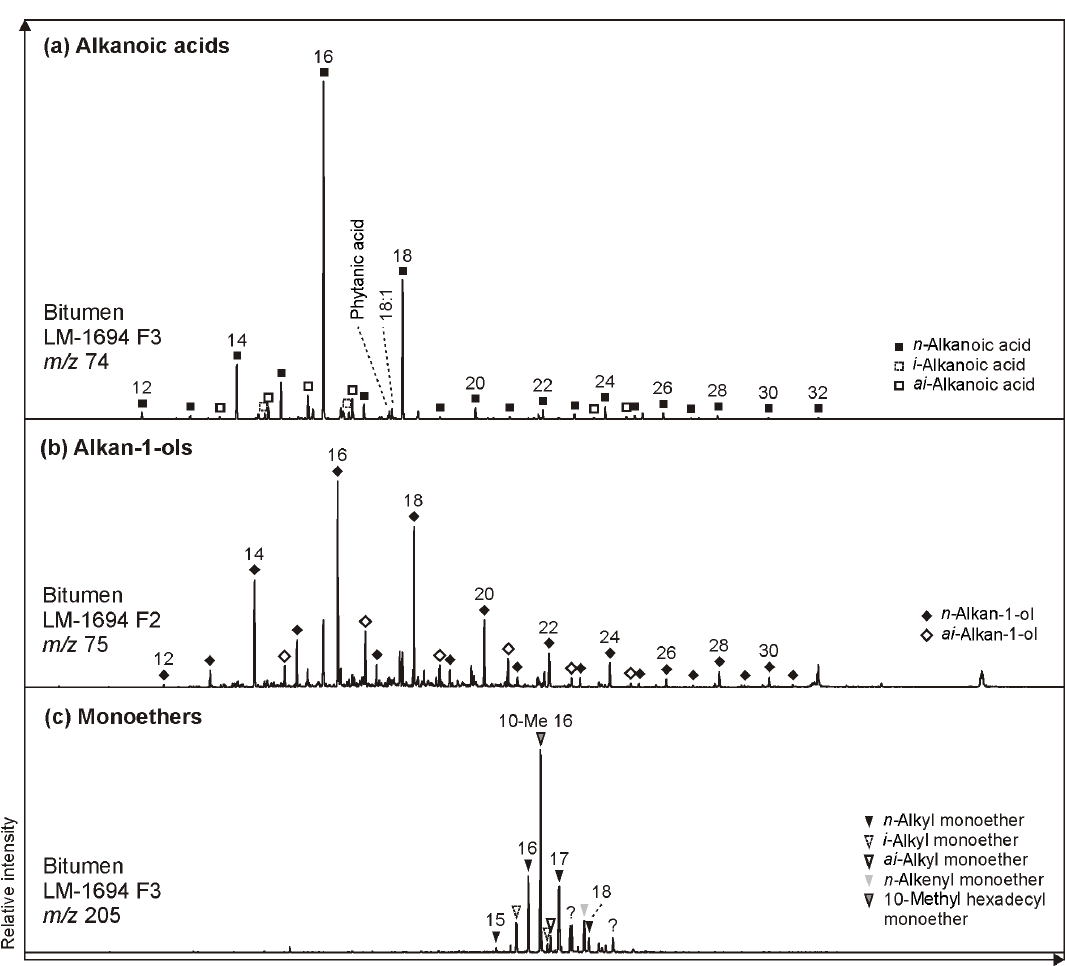
Figure 4. Partial GC-MS ion chromatograms (10–60min) of the derivatized alcohol/ketone (F2; alcohols were measured as trimethylsilyl ethers) and polar (F3; carboxylic acids were measured as methyl esters) fractions from bitumen of the High Magadi Bed chert LM-1694. Alkanoic acids ( m/z 74; a ) and alkan-1-ols ( m/z 75; b ) show a clear even-over-odd predominance and dominances of linear C 16 and C 18 homologues. (c) Distribution of glycerol monoethers ( m/z